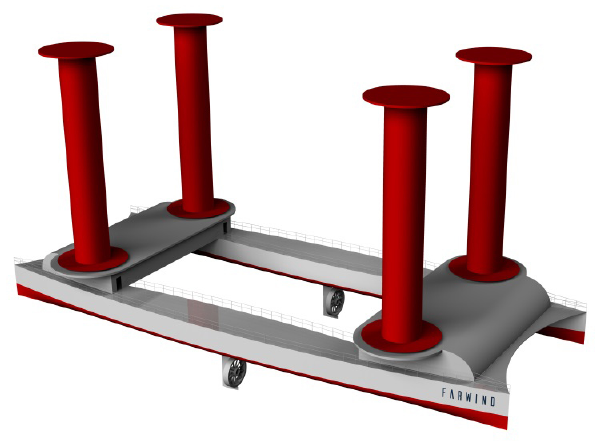
Figure 8. Artist’s view of the proposed energy ship